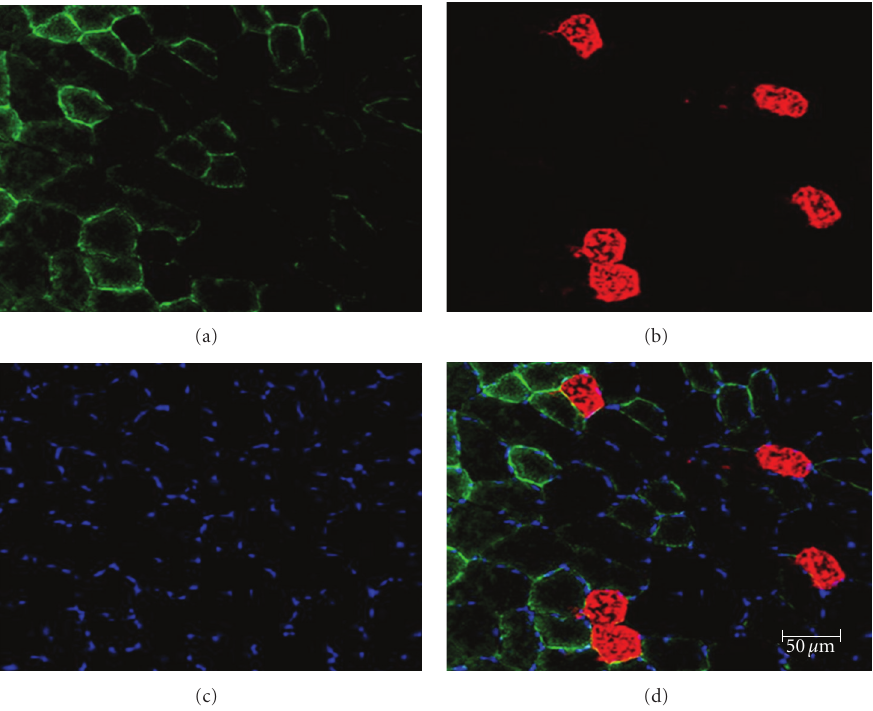
Figure 3: Staining of LDs with BODIPY (493/503) in cross section of rat tibialis anterior (TA) muscle demonstrates that LDs are not limited to muscle fibers expressing slow MHC. (a) Fibers stained with BODIPY (green) demonstrate the appearance of spherical LDs within the muscle fibers as previously described with Oil Red O staining procedures. (b) Slow fibers were labeled using an antibody specific for the slow form of MHC (red). (c) Nuclei were stained with DAPI (Blue). (d) Merged triple label image of the muscle section demonstrates fibers presenting with substantial BODIPY signal that do not label for slow MHC. All images were taken at 10x, and a scale bar is provided for